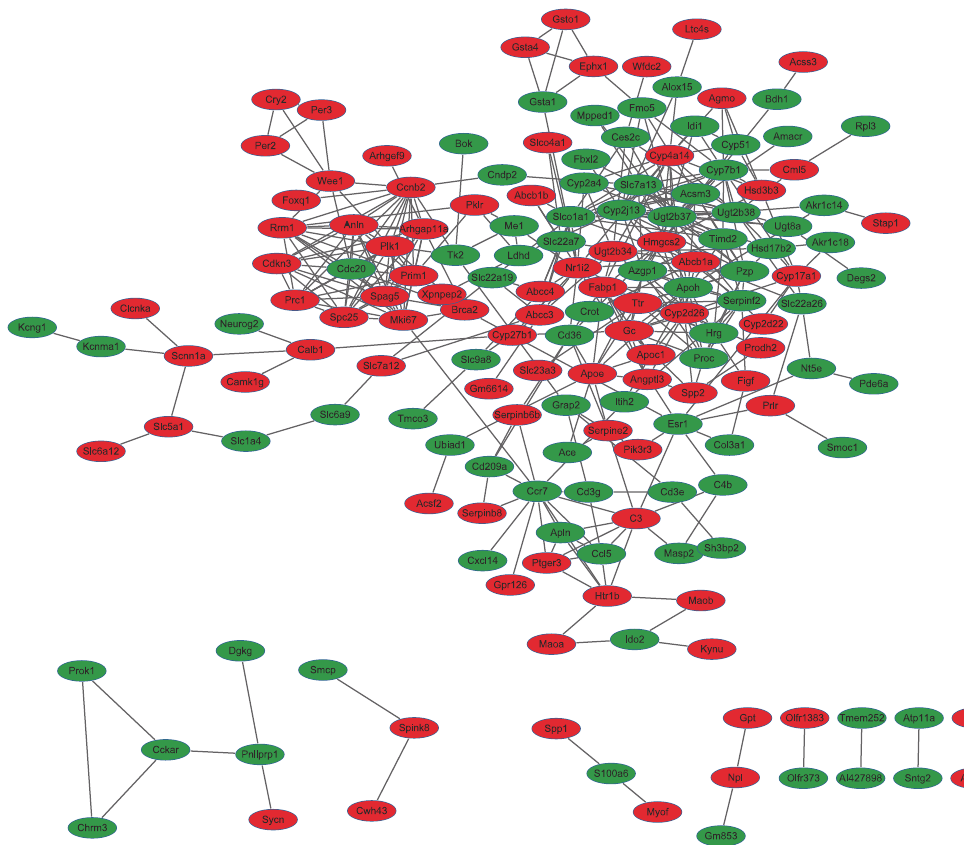
Figure 5: Interactome of the 355 genes showing 166 nodes and 411 edges in the protein-protein interaction map encompassing 4 clusters in DN. Genes are denoted as nodes in the graph, and interactions between them are presented as edges. Green indicates downregulated genes, whereas red indicates upregulated genes.